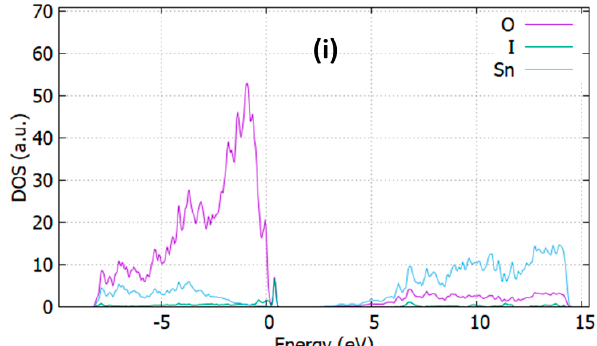
Figure 3. pDOS graphs of ( a ) undoped SnO 2 , ( b ) F i doped SnO 2 , ( c ) Fo doped SnO 2 , ( d ) Cl i doped SnO 2 , ( e ) Clo doped SnO 2 , ( f ) Br i doped SnO 2 , ( g ) Br O doped SnO 2 , ( h ) I i doped SnO 2 , and ( i ) I O doped SnO 2.